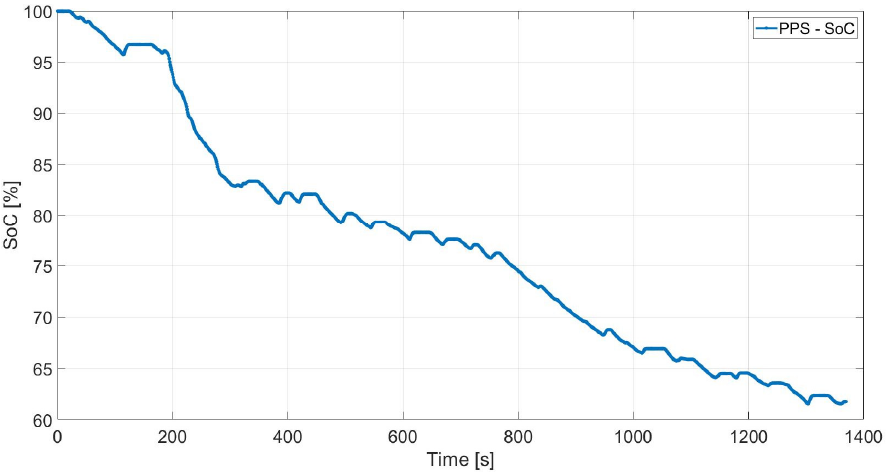
Figure 12. SOC Profile vs. Time.